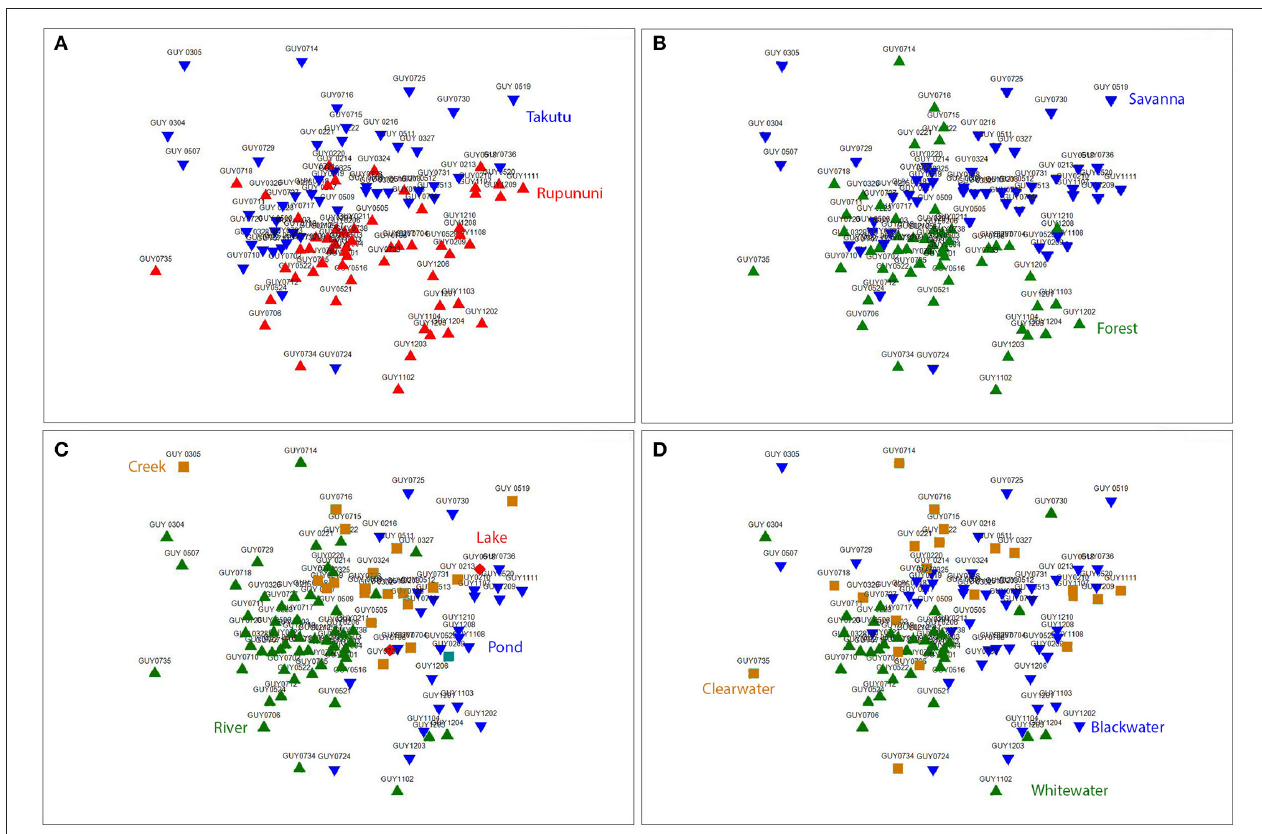
FIGURE 3 | Nonmetric multidimensional scaling (NMDS) ordination ( k = 2) based on Jaccard’s similarity matrices for Takutu and Rupununi Rivers of fish communities, stress = 0.21. (A) river drainage (Rupununi vs. Takutu), (B) vegetation (forest vs. savanna), (C) water body type (river, creek, lake or pond), and (D) water chemistry (blackwater, whitewater, or